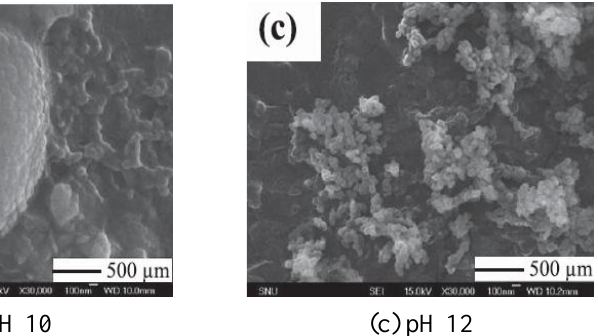
OH (from Ahn et al . [49] with permission of 4